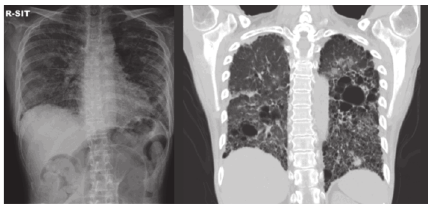
Figure 1: Chest radiography and CT findings at the emergent admission. Diffuse ground glass or reticular shadow with honey combing appearance in both lung